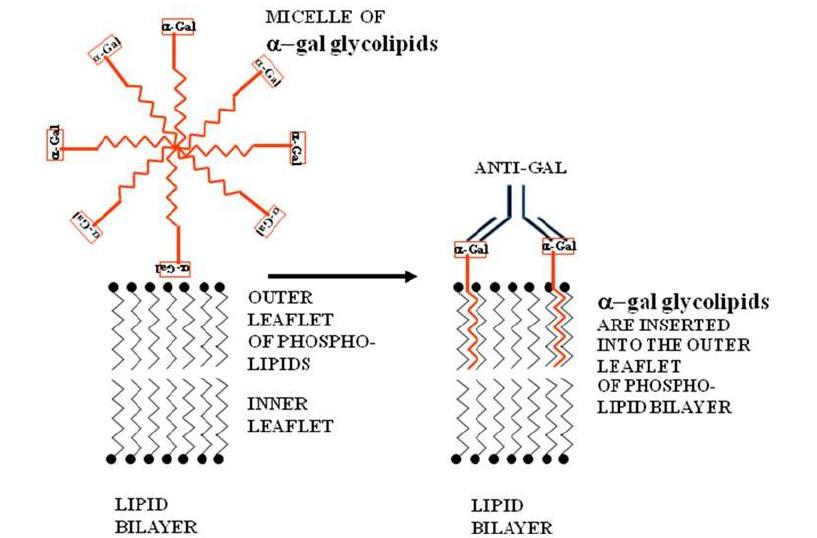
Figure 2. Insertion of  -gal glycolipids into the lipid bilayer of tumor cell